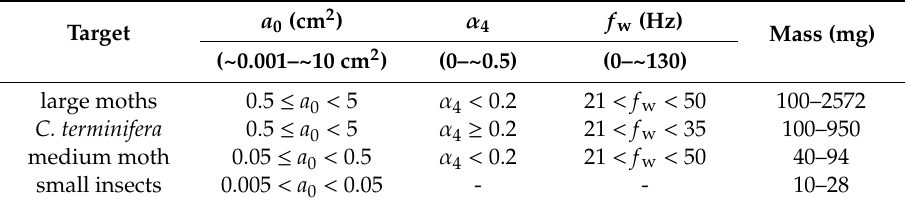
Table A2. Previous radar-target-class selection criteria for the Australian Plague Locust C. terminifera , large moths, medium moths and small insects [22]. The size parameter a 0 of the target, one of the two shape parameters α 4 and the fundamental or wingbeat frequency f w are used to classify the radar targets. Note there is no selection on α 2